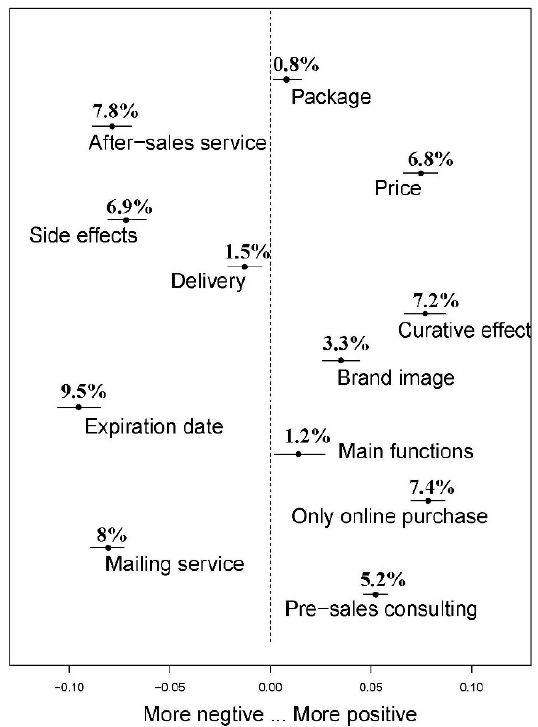
Figure 3. Change in topic prevalence based on review extremity (positive vs. negative).